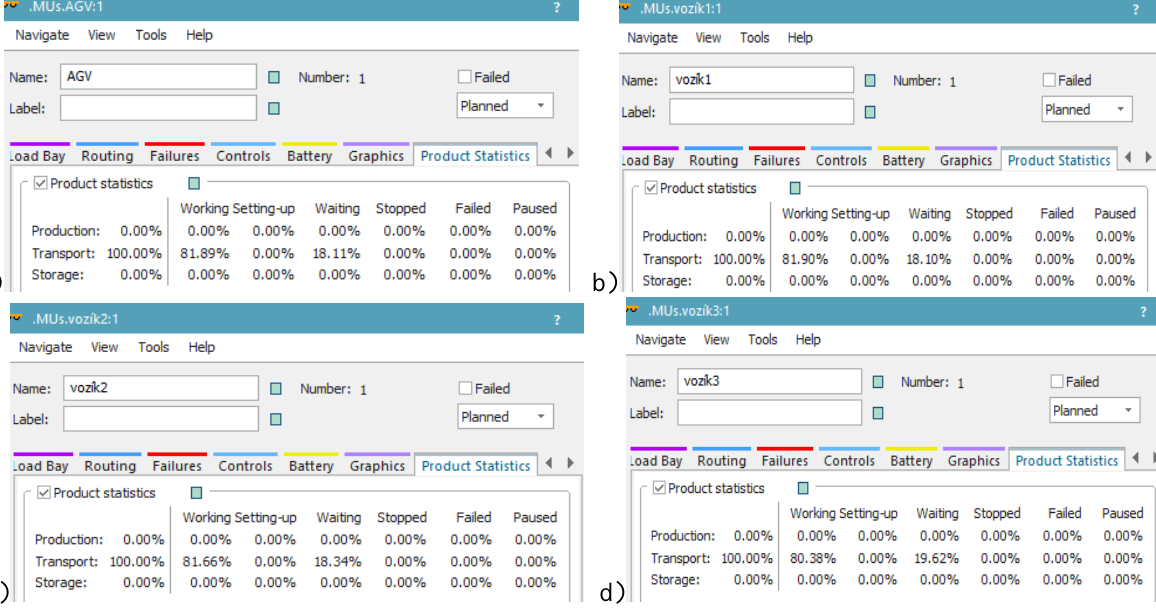
From the simulation model with cancelled three